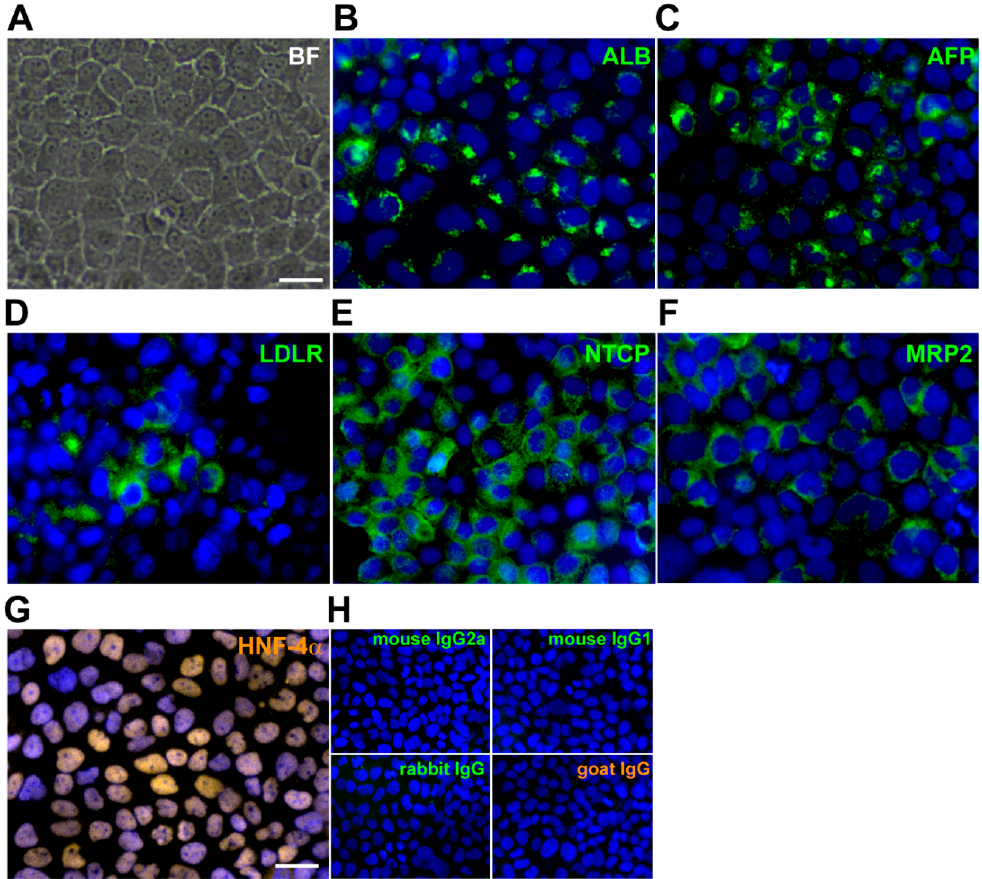
Figure 1. Identification of hepatic markers and the hepatitis B virus (HBV) entry receptor (NTCP) in immortalized human hepatocyte-like cell (imHC). imHCs were maintained in DMEM/F12, 10% fetal bovine serum. After reaching confluence, cells exhibited a usual hepatocyte morphology, including a polygonal shape, binucleated and cord-like structure ( A ). Hepatic phenotypes were examined using immunofluorescence staining for the following major hepatocyte markers: Albumin (ALB) ( B ), α -fetoprotein (AFP) ( C ), low-density lipoprotein receptor (LDLR) ( D ), Na + -taurocholate cotransporting polypeptide (NTCP) ( E ), multidrug resistance-associated protein 2 (MRP2) ( F ), hepatocyte nuclear factor-4-alpha (HNF-4 α ) ( G ) and an isotype control ( H ). Cell nuclei were visualized using Hoechst 33342 DNA dye. Fluorescence images were captured and analyzed using an Operetta High-Content Imaging System (PerkinElmer, Waltham, MA, USA) with a ×40 objective lens. Scale bar = 50 µm. The presence of hepatic marker in imHCs was quantified from 15 randomly selected image fields (total number of analyzed cells > 2000).